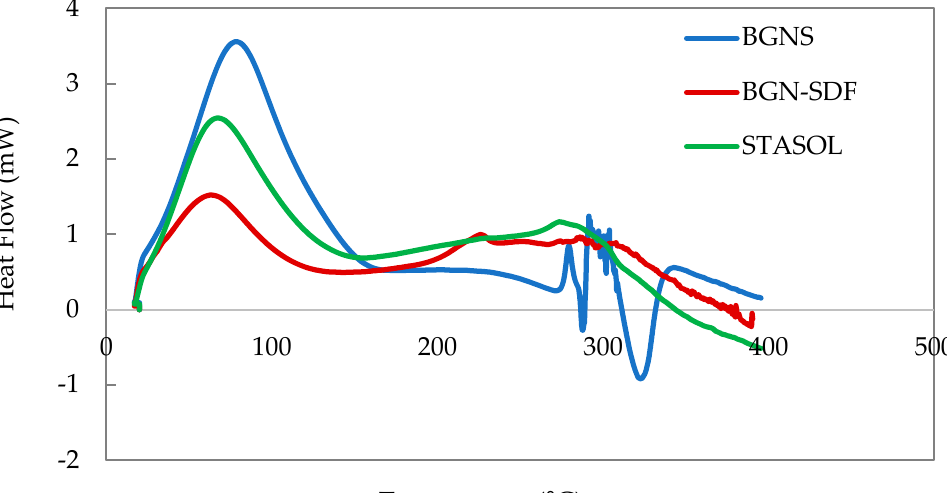
Figure 7. Thermal properties of BGNS, BGN-SDF and STASOL using differential scanning colorimetry (DSC). BGNS = Bambara groundnut starch; BGN-SDF = Bambara groundnut soluble dietary fibre; STASOL = Bambara groundnut starch-fibre nanocomposite.